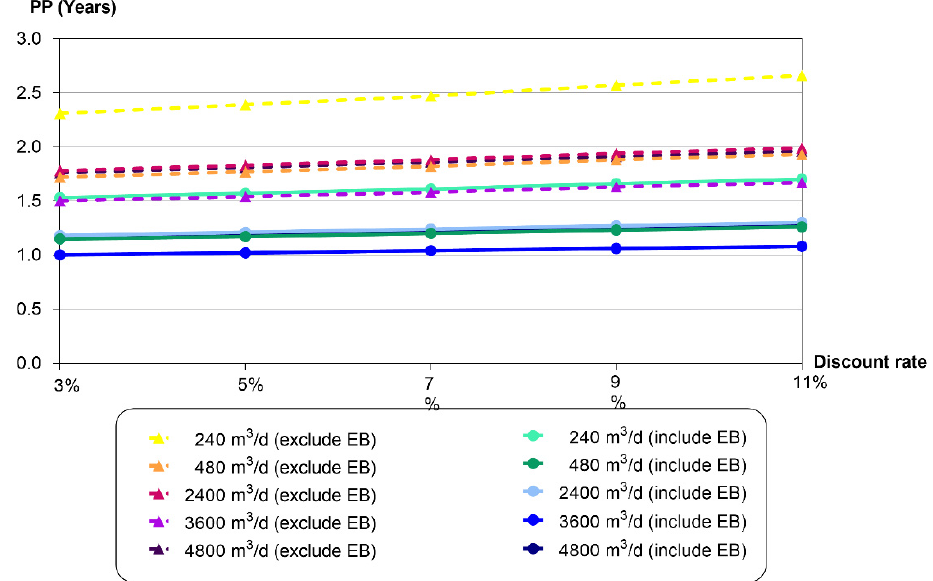
Figure 8. Payback periods (PPs) for water reclamation projects for the irrigation of plants and green areas when including and excluding environmental benefits (EB).